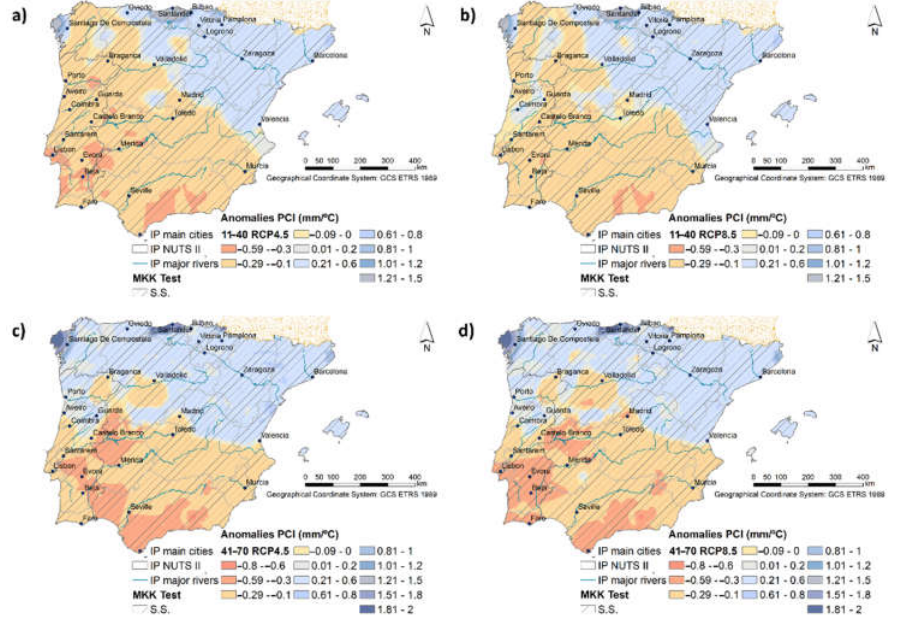
Figure 7. PCI anomalies (Mann–Whitney–Wilcoxon test at a 5% significance level) for the period ( a , b ) 2011–2040, ( c , d ) 2041–2070, with respect to the baseline climate (1961–1990), under RCP4.5 ( left ) and RCP8.5 ( right ).